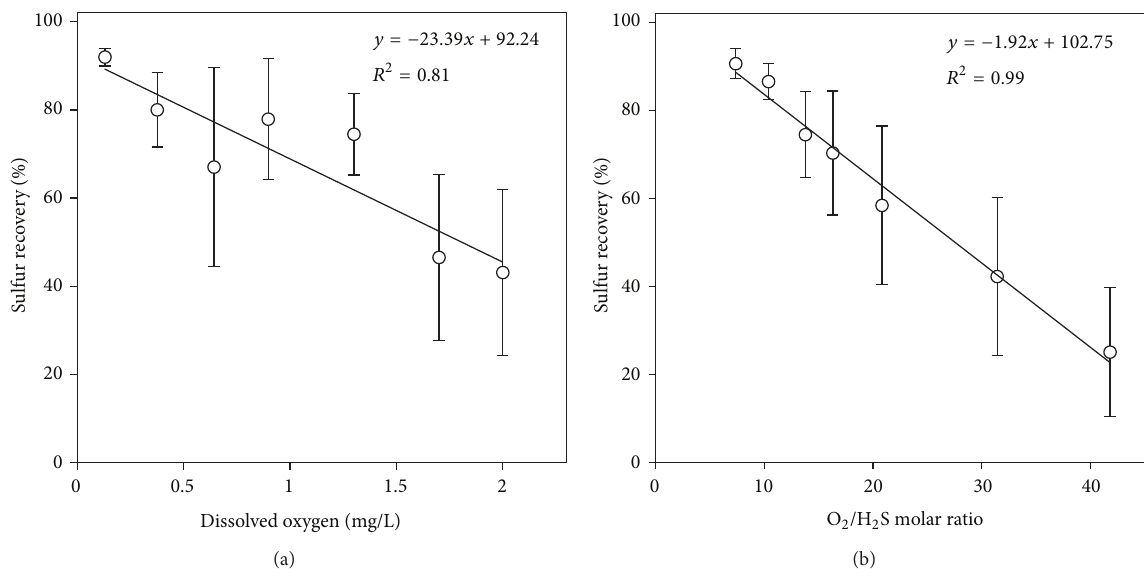
Figure 4: Effect of oxygen availability as (a) DO and (b) O 2 /H 2 S molar ratio on sulfur